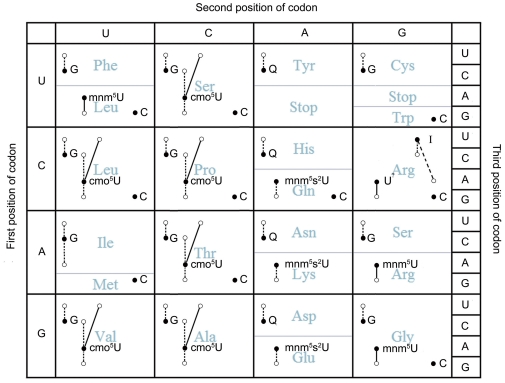
Different tRNA modifications are likely to correlate with the codon pairing patterns observed in bacteria.The location of a black dot represents the codon recognized by a cognate tRNA through Watson-Crick pairing, and the first anticodon base (with or without modifications) of the tRNA is provided next to the black dot. According to wobble rule, the tRNA is able to recognize other synonymous codons (white circles). However, our analysis of the synonymous codon pairing pattern in bacteria supports the hypothesis that the other synonymous codons are recognized in a discriminated way. In the Ala, Leu4, Pro, Ser4, Thr, and Val codon families, the tRNA with a modified cmo5U at the wobble position would prefer A- and U-ending codons (linked with solid lines), but avoid C- and G-ending codons (linked with dashed lines). However, in Arg2, Arg4, Gly, and Leu2 codon families the tRNA with a modified mnm5U (not confirmed for Arg4 as yet) at the wobble position would prefer A- and G-ending codons instead (linked with solid lines). In the Gln, Glu and Lys codon families, the tRNA with a modified mnm5S2U at the wobble base would only prefer A-ending codons and avoid G-ending codons (linked with dashed lines).